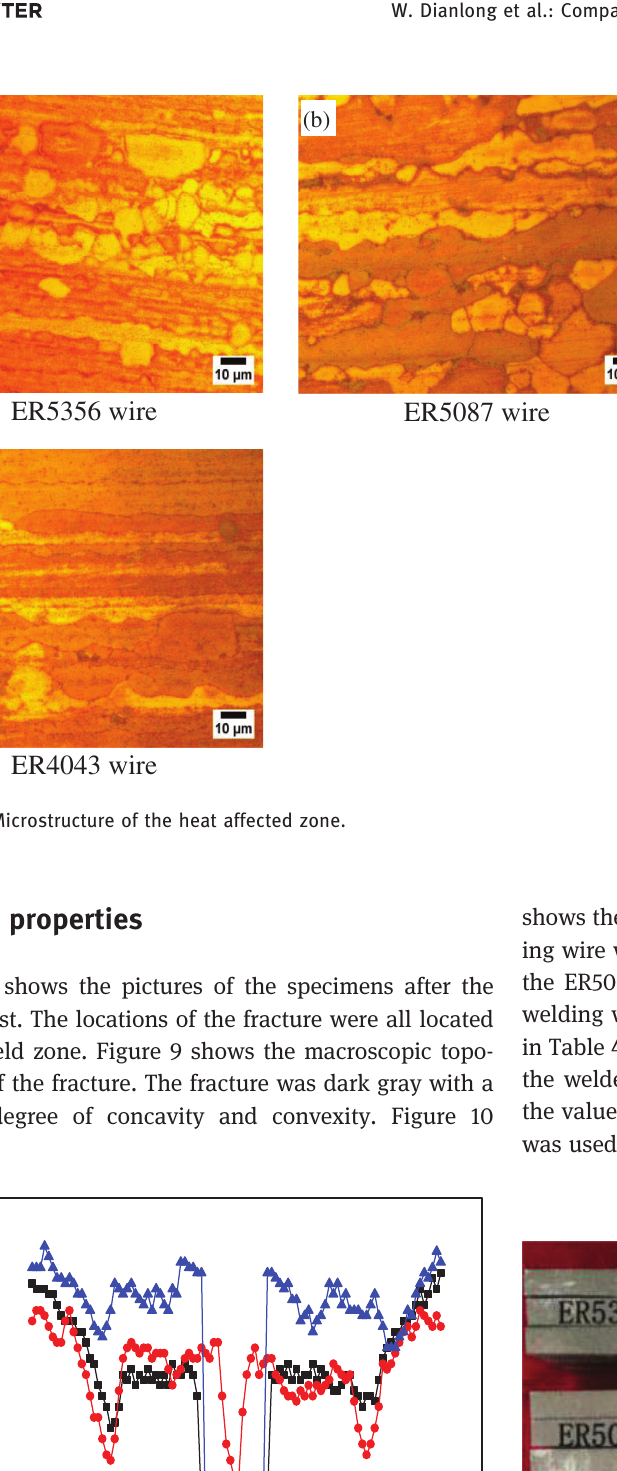
Figure 8: Fracture images of